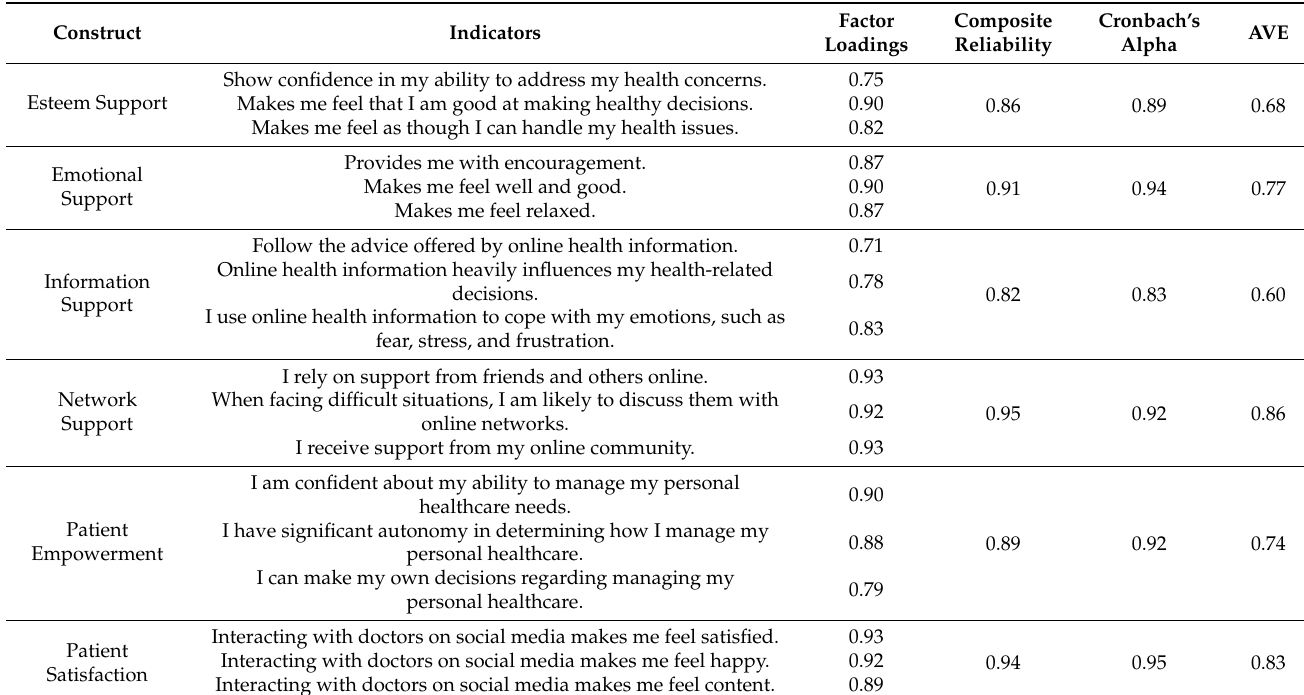
Table 4. Construct measures.